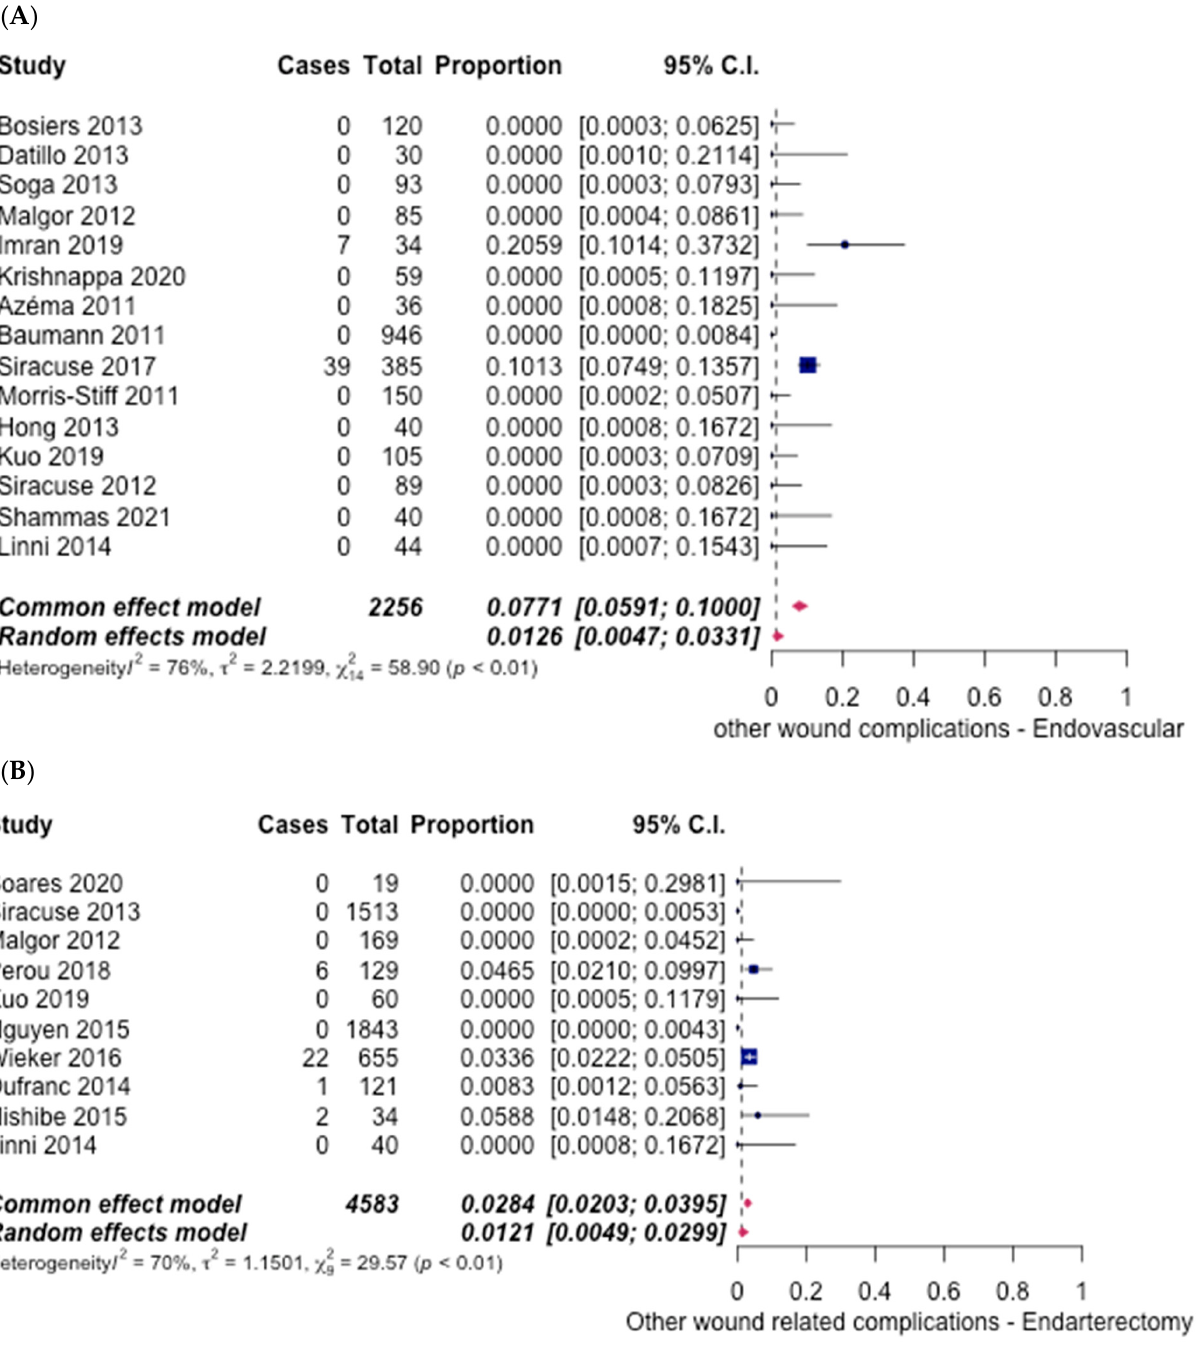
Figure 13. Forest plot for other wound-related complications. ( A ) Endovascular intervention [6,8,10,12–22,27]. ( B ) Endarterectomy [6,13,21,23–26,28–30]. The rates of stent fracture were reported in 12 studies [6,8,10,12,14–21] for ET and 3 studies [6,21,29] for FAE. The ET group observed an overall rate of only 1.09% (95% CI [0.47%, 3.33%]) (Figure 14A), while the FAE group reported an overall rate of 0.3% (95% CI [0.03%, 3.15%]) (Figure 14B). The pooled odds ratio was 3.66 (95% CI [1.48–9.05], p < 0.05), in favour of the FAE group.